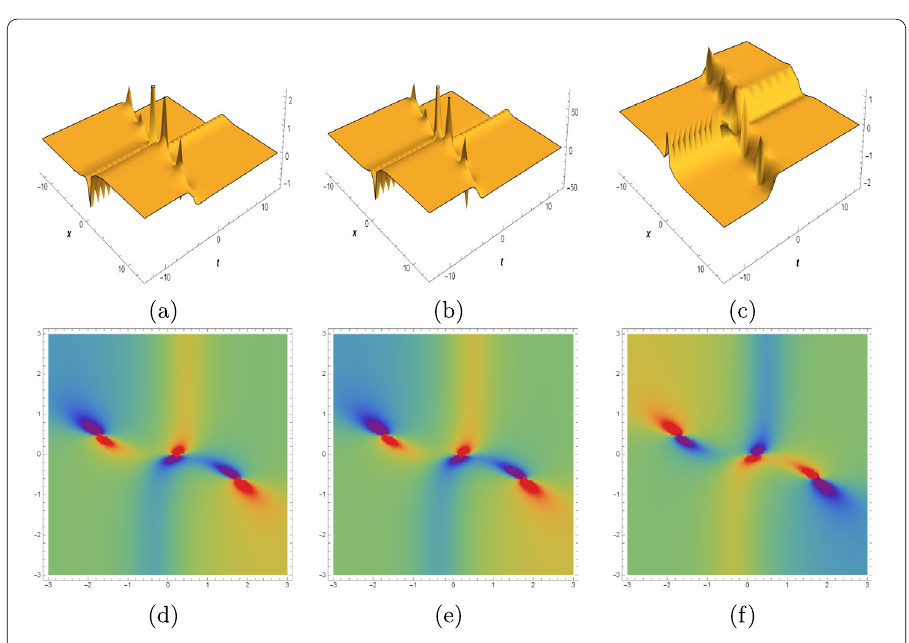
Figure 6 The 3D and density profiles of imaginary part of Eq. (16) for c 1 = 0.74, b 6 = –1, b 5 = –1, c 2 =